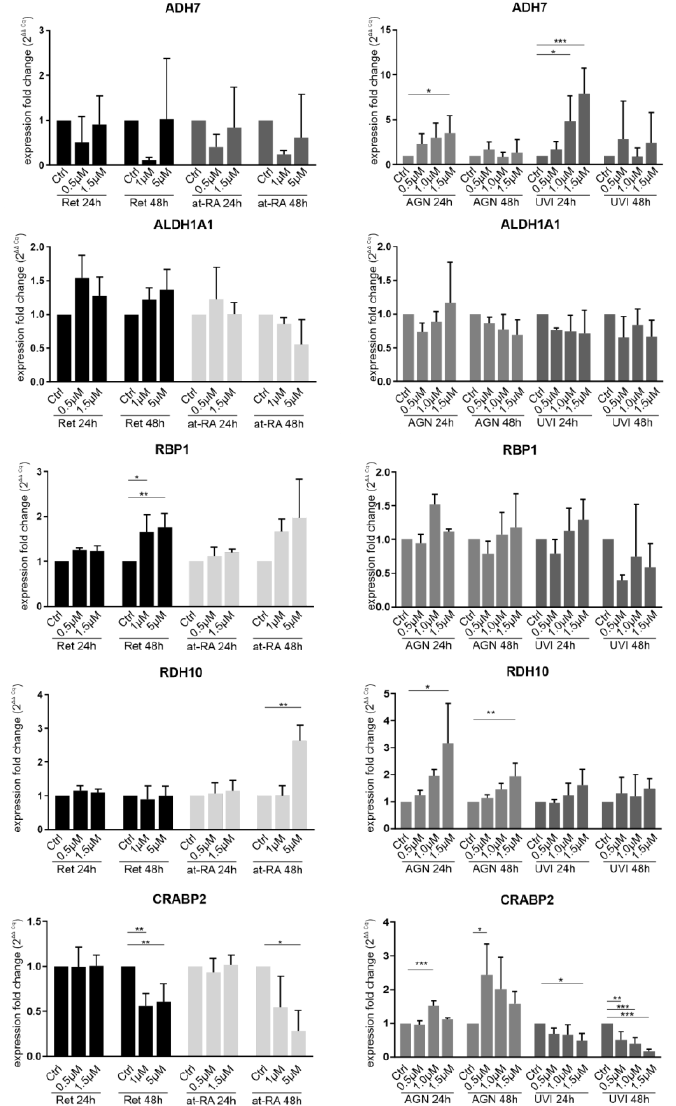
Figure A1. qRT-PCR analysis of ADH7, ALDH1A1, RBP1, RDH10, and CRABP2 transcripts in primary limbal epithelial cells (LEC) treated with retinol (Ret), all trans-retinoic acid (at-RA), AGN 193109 (AGN), or UVI 3003 (UVI), for 24 h and 48 h, respectively. The transcripts shown here are related to retinoic acid pathways (from literature search) and were found to be deregulated in the conjunctiva of aniridia patients [9]. ADH7 showed a tendency for downregulation after the 48 h treatment with 1 µM Ret or at-RA. The 1.5 µM AGN treatment for 24 h led to the upregulation of ADH7 (FC = 3.5). The 1.0 µM and 1.5µM UVI treatment for 24 h also led to a significant upregulation of ADH7 (FC = 4.9 and FC = 7.9). ADLH1A was not significantly affected by any of the treatments. RBP1 showed significant upregulation after Ret treatment for 48 h using the 1 µM (FC = 1.6) and 5 µM (FC = 1.8) concentration. RDH10 was upregulated after the 5 µM RA treatment for 48 h (FC = 2.6). AGN treatment also led to upregulation using the 1.5 µM concentration for 24 h (FC = 3.2) and 48 h (FC = 1.9). CRABP2 was significantly downregulated after the 48 h Ret treatment with the 1 µM (FC = 0.6) and at 5 µM concentrations (FC = 0.6). The 5 µM RA treatment for 48 h led to the down- regulation of CRABP2 (FC = 0.3). AGN treatment led to CRABP2 upregulation after the 24 h treat- ment with 1.0 µM (FC = 1.5) and after the 48 h treatment with the t0.5 µM concentrations (FC = 2.4). UVI treatment led to significant CRABP2 downregulation after 24 h using the1.5 µM (FC = 0.5) con- centrations and after 48 h for all of the used concentrations (FC = 0.5–0.2). * p ≤ 0.05; ** p ≤ 0.01; *** p ≤ 0.001; n = 3.